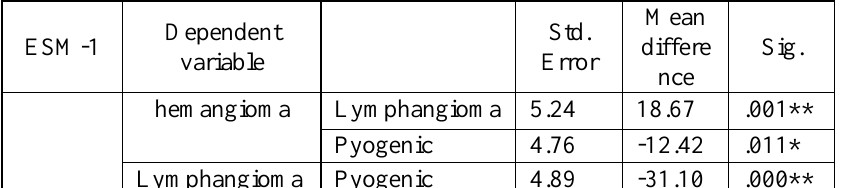
Table (2): several statistical comparisons by post hoc test